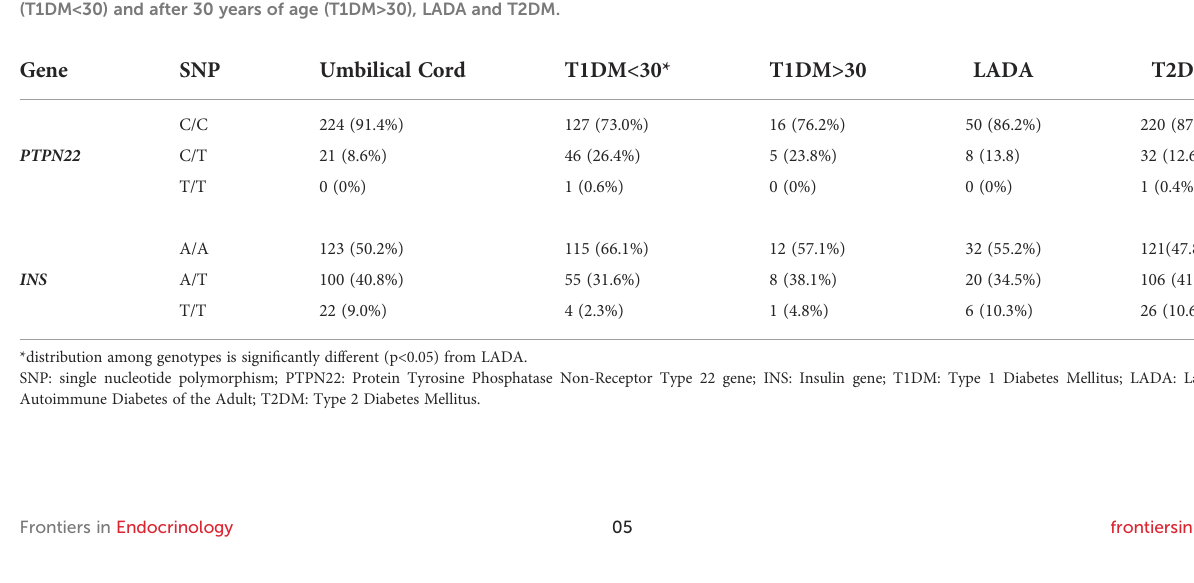
TABLE 4 Polymorphisms in PTPN22 and INS gene analysis in samples from controls (umbilical cord) and patients diagnosed with T1DM before (T1DM<30) and after 30 years of age (T1DM>30), LADA and T2DM. Gene